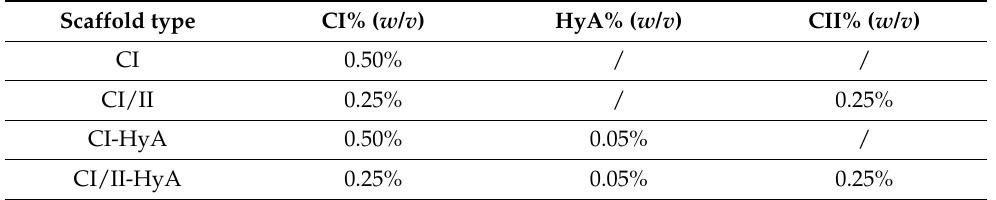
Table 1. Experimental collagen-based scaffolds manufactured and investigated for cartilage-like tissue regeneration. Scaffold biomaterials composed of type I collagen (CI) and type II collagen (CII) at various ratios were prepared to a final collagen concentration of 0.5% ( w / v ), in the presence or absence of hyaluronic acid (HyA) at concentration of 0.05% ( w / v ). Scaffold